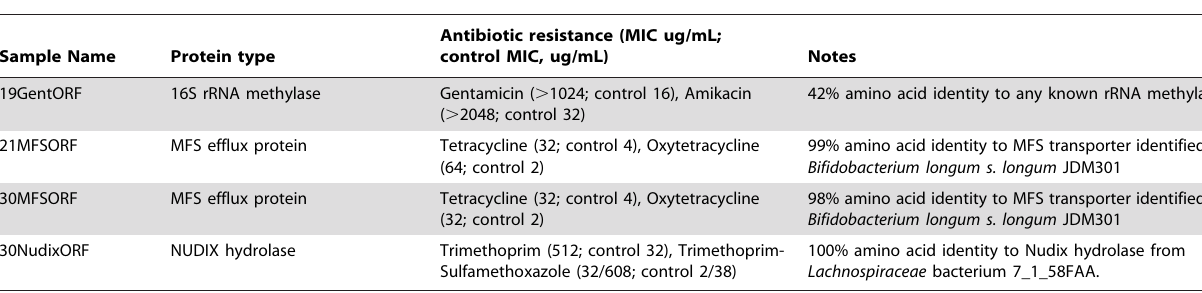
All three tetracycline resistance ( tet ) gene categories (ribosomal protection proteins, MFS and multi antimicrobial extrusion (MATE) transport proteins, and flavin-dependent monooxygen- ases) were identified (Table S8 in File S1), with multiple tet genes Table 2. Putative novel resistance